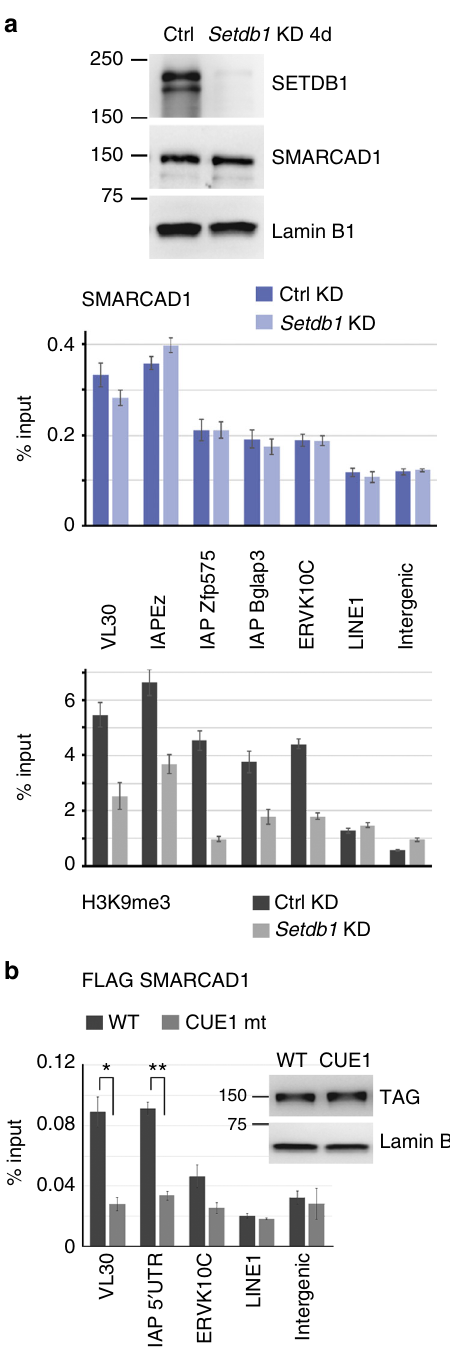
Fig. 5 SMARCAD1 binding to ERVs is not dependent on SETDB1 but on KAP1. a Western blot analysis in E14 mESCs transfected with a Setdb1 shRNA (KD) or a non-targeting control (Ctrl) 96 h post transfection shows ef fi cient knockdown. SMARCAD1 levels were not affected. Lamin B1 serves as loading control. Single-cross-linked chromatin was prepared from these cells and ChIP was carried out with H3, H3K9me3, SMARCAD1, and KAP1- speci fi c antibodies. qPCR over retrotransposons reveals a clear reduction of H3K9me3 but not of SMARCAD1 over class I (VL30) and class II (IAPs, MMERVK10C) ERVs upon Setdb1 knockdown. Data are representative of two immunoprecipitations and the error bars denote the mean ± S.E. of technical triplicates. Corresponding H3 and KAP1 ChIPs are shown in Supplementary Figure 9a. b Stable association of SMARCAD1 with ERV subfamilies depends on an intact CUE1 domain in SMARCAD1. ChIP-qPCR analysis in ESCs depleted for 2 days of endogenous SMARCAD1 protein but expressing 3X FLAG tagged SMARCAD1, either WT or a mutant that affects its interaction with KAP1 (CUE1 mt, F168K, L195K 25 ). Western blot shows that tagged WT and CUE1 mutant SMARCAD1 proteins are expressed at similar levels in the cells utilized for ChIP. ChIP was carried out with a FLAG-speci fi c antibody on double-cross-linked chromatin and analysed by qPCR. Depicted is the mean ± S.E. from three biological replicates ( n = 3). P- values are from paired two-tailed Student ’ s t -test: * p